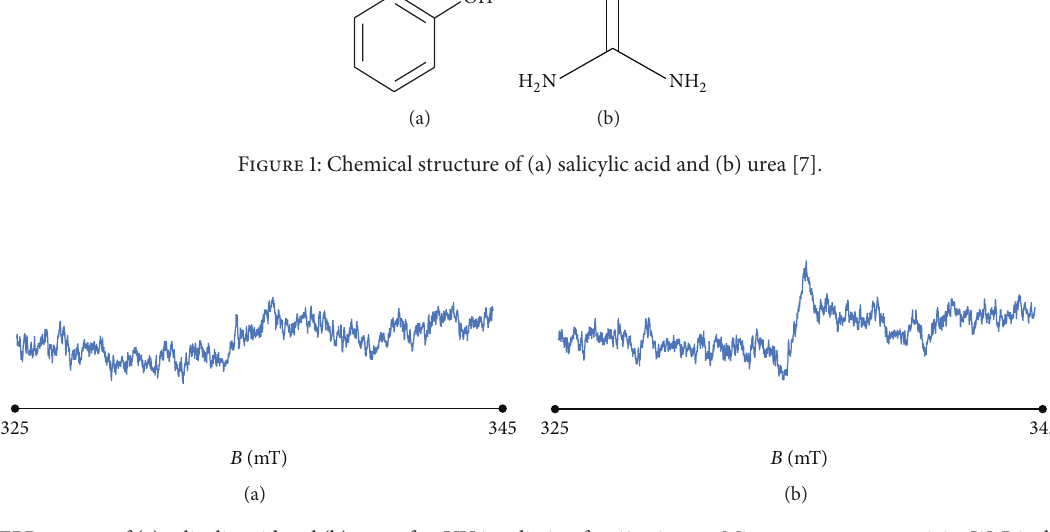
(Germany) with 4 radiators with power of 20 W. The distance of the samples from the lamp was 30